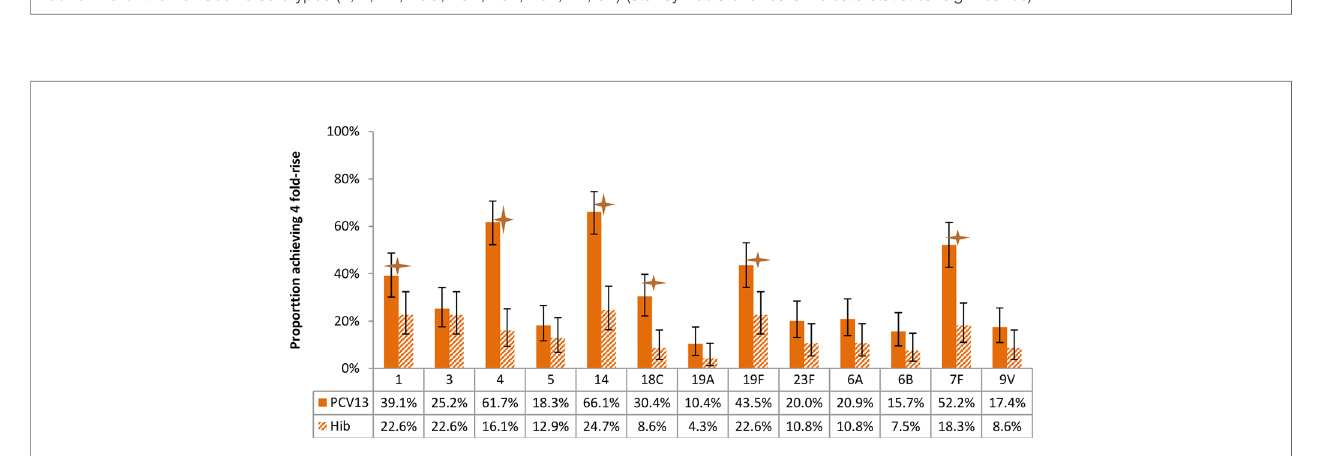
FIGURE 7 | Proportion of participants achieving 4-fold rise of antibody concentration after vaccination, by arms. Statistically higher proportion of participants with 4- fold rise of antibody was found in PCV13 vaccinees for 6 of the 13 vaccine serotypes (1, 4, 14, 18C, 19F, 7F) (star symbols over bars indicate statistical signi fi cance).